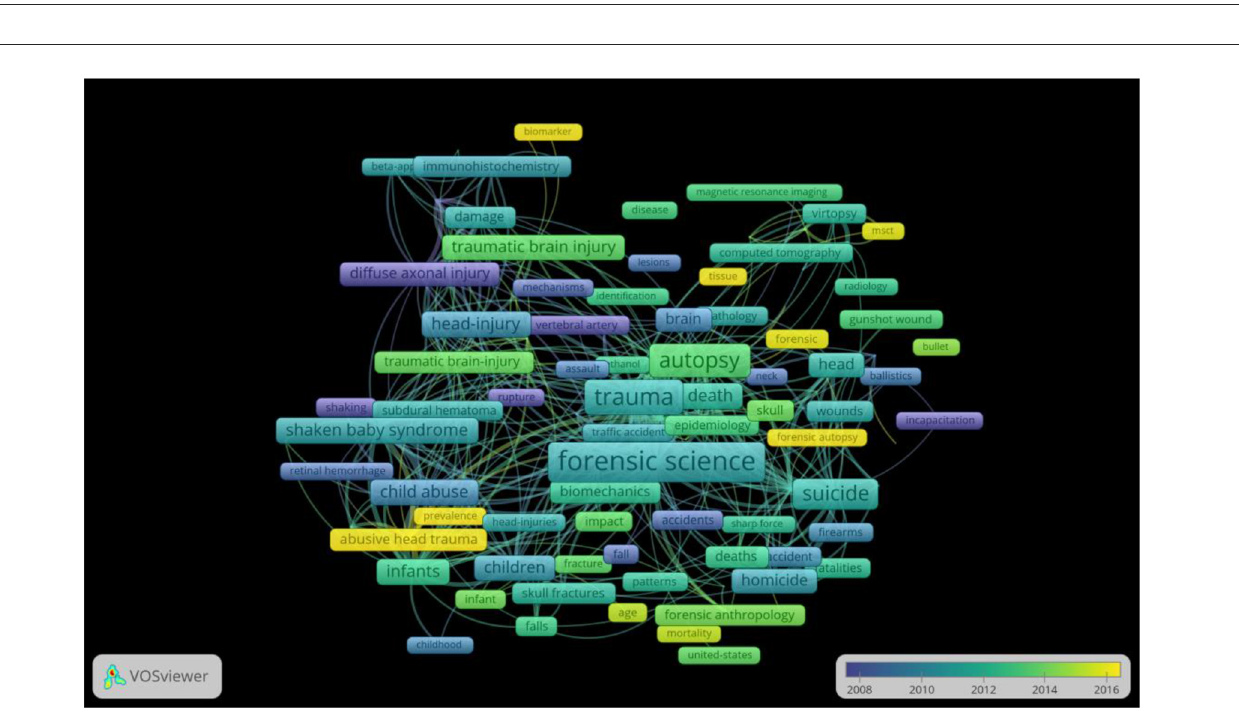
FIGURE4 Network Visualization map for keywords plotted with VoSviewer 1.6.14. The size of the circles indicates the number of publications. The link strength between the circles reflects the frequency of co-occurrence. The different colors represented the average year the keywords appeared. The analysis method was